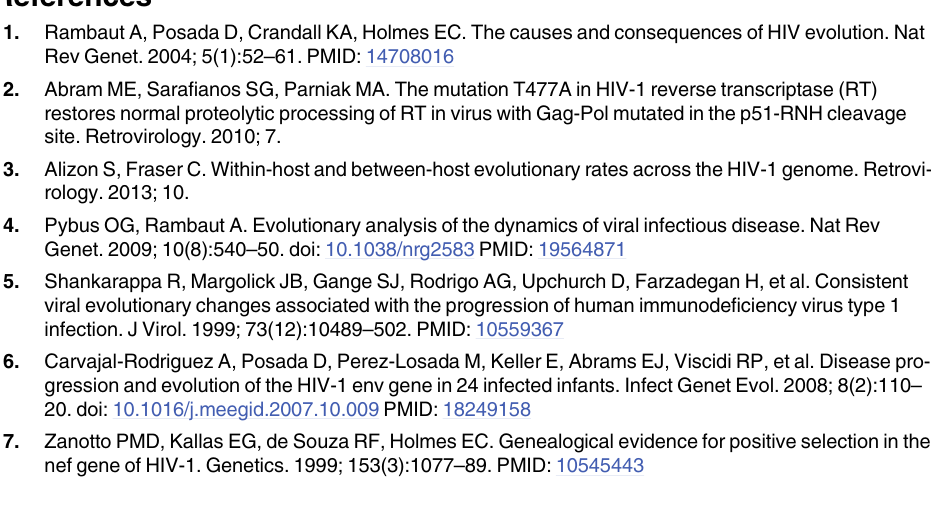
S1 Table. Clinical information for all 24 patients. S2 Table. Assuming equal codon frequencies and an equal transition/transversion ratio, codon positions where any nucleotide mutation results either a silent or replacement change are assigned 1 and 0, respectively. Codon positions where silent and replacement change are possible are assigned 0.5. As a consequence, the probability of observing a silent mutation, p(s), at the three codon positions are 0.0625, 0.0, and 0.711. The probability